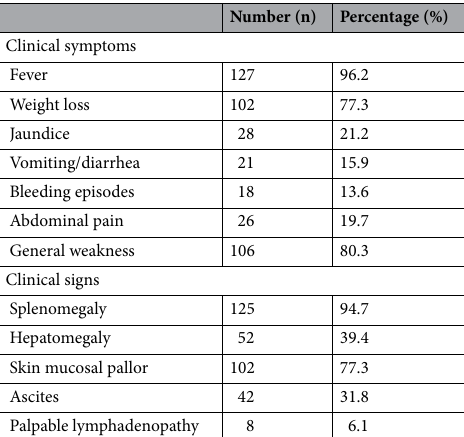
Number (n) Percentage